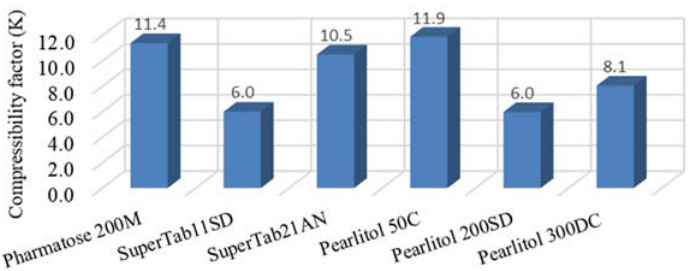
Figure 4. Compressibility factor for different powders.